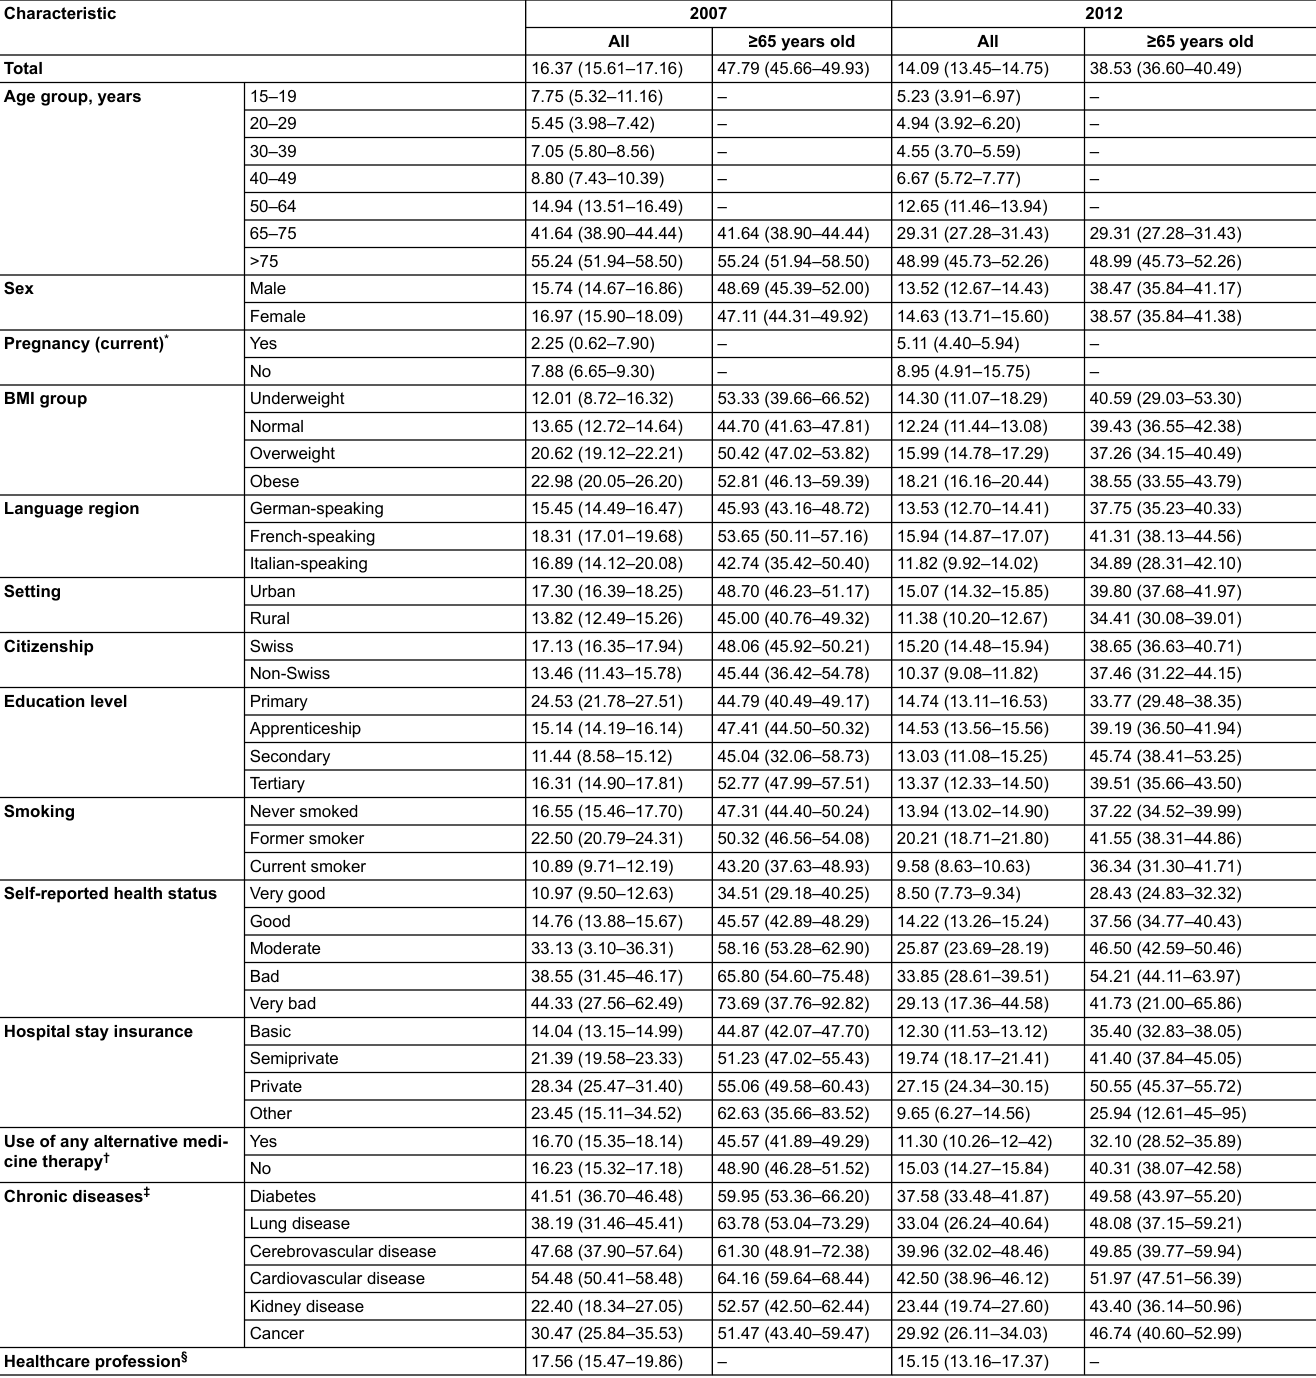
Table 1: Percent of people reporting having been vaccinated for influenza in the last 12 months in Switzerland, 2007 and 2012, overall and among people ≥65 years old. Results are presented as % (95% confidence interval).